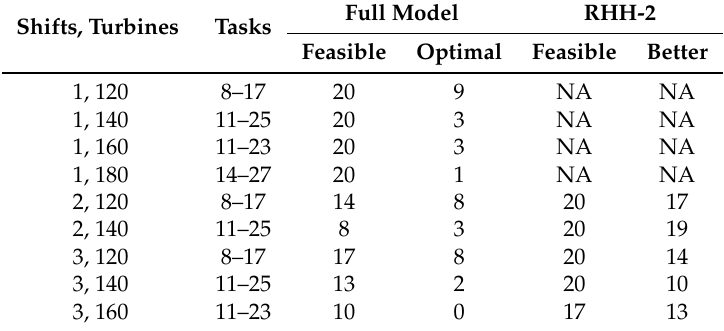
Table 1. Test instances used to evaluate efficiency of full model, with results from using the full model and the RHH-2 heuristic with symmetry breaking constraints. For each group of instances, 20 random instances are generated with different maintenance tasks included. Full Shifts, Turbines Tasks